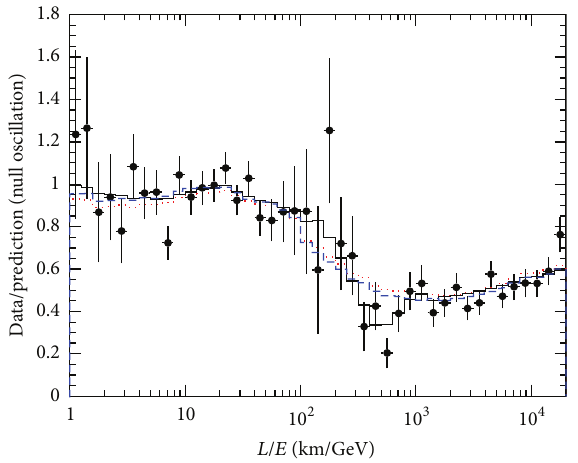
Figure 9: Data/MC ratio versus 𝐿/𝐸 ] (black points) for SK. The red solid line is the MC expectation with |Δ𝑚 2 23 | = 2.5 10 −3 eV 2 and maximal mixing [66,